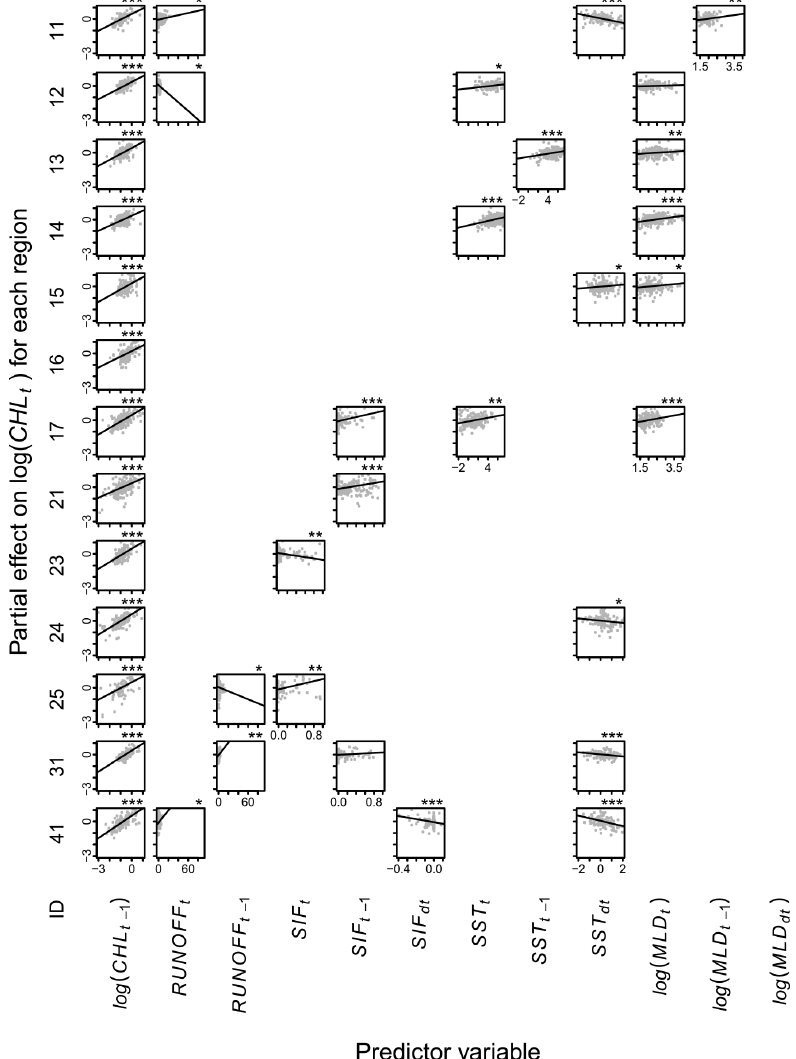
Figure A3. Partial effects of environmental variables on chlorophyll a , CHL, within 20 to 50km from the coast. Each row shows the model (Eq. 1) for one hydrological region (Table 1). Each panel shows the relationship between a predictor variable ( x axes) and CHL ( y axes), with lines showing estimated partial effects and points showing partial residuals. Blank panels imply that the variable was not selected. Asterisks show statistical significance at levels 5% ( ∗ ), 1% ( ∗∗ ) or 0.1% ( ∗∗∗